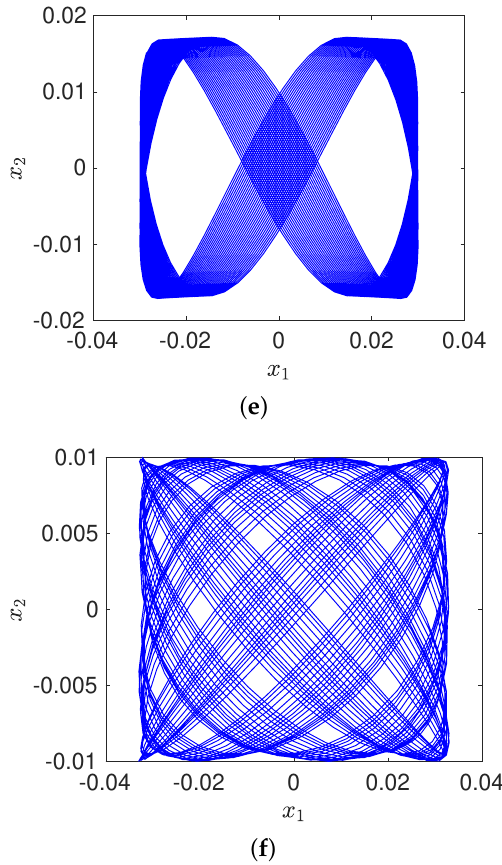
Figure 4. ( a – f ) Phase portraits of the charged dilaton black hole system corresponding to the six groups in Table 1 when (cid:101) = 0.001.